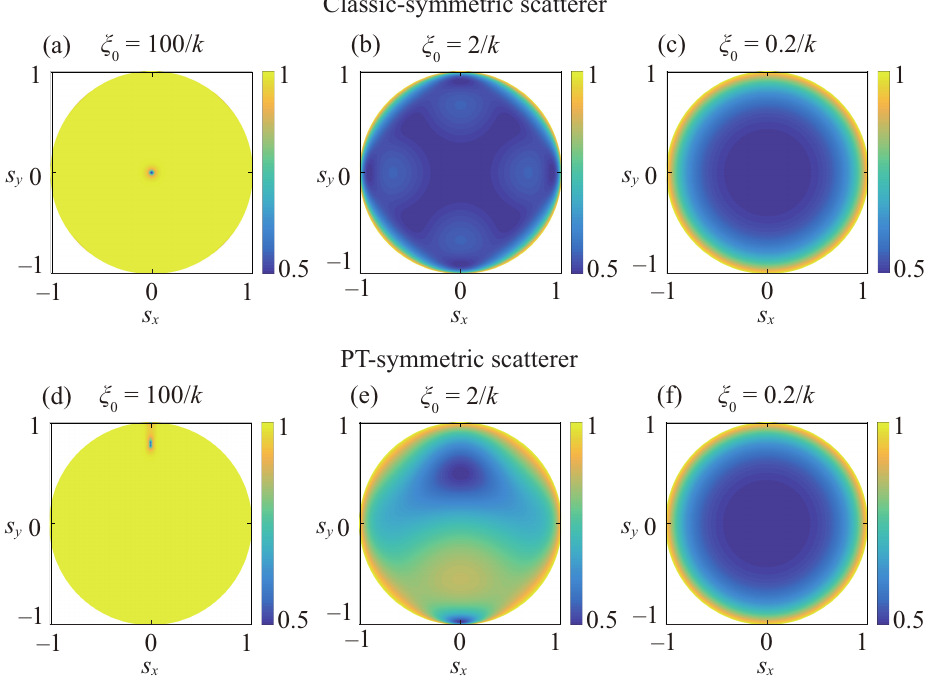
Figure 5. Simulation results for the 3D degree of polarization of the far-zone scattered field by a four-point scatterer having ( a – c ) classic-symmetric potential and ( d – f ) PT-symmetric potential. The incident beam is a partially coherent radially polarized beam with the GSM correlation function having a varying spatial coherence width: ξ 0 = 100/ k ,2/ k , and 0.2/ k